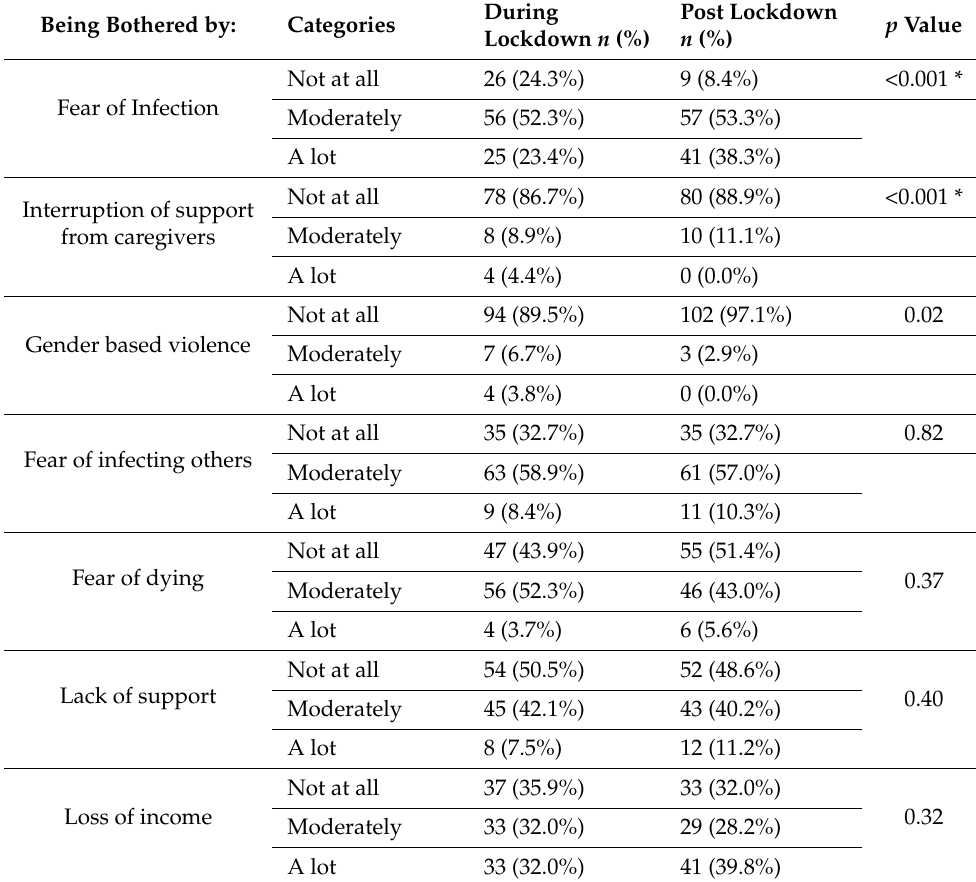
Table 3. Comparison of respondents’ feelings during lockdown and post